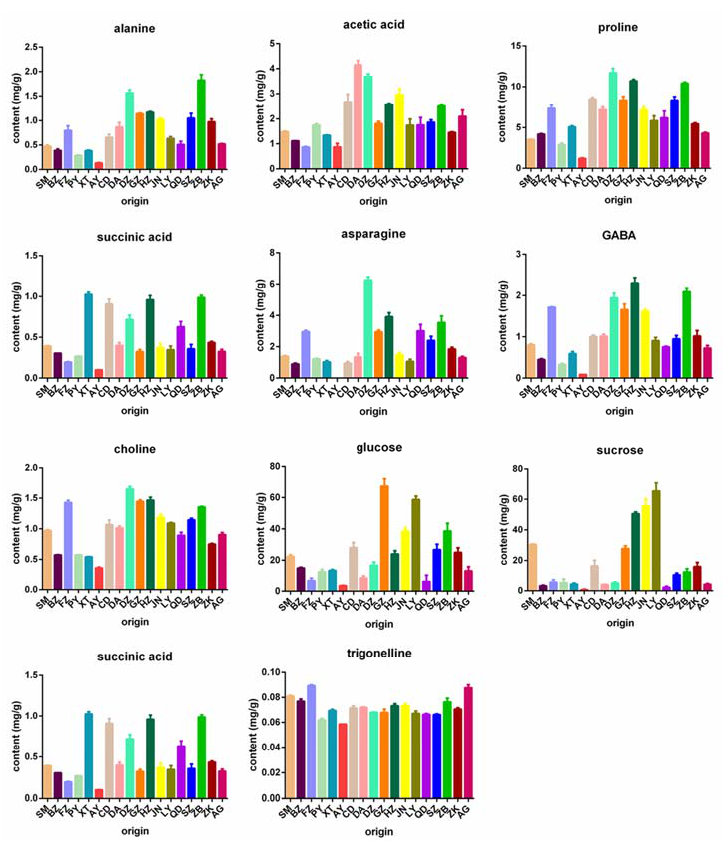
Figure 3. The contents of 11 metabolites in mulberry leaves extracts from 17 origins.